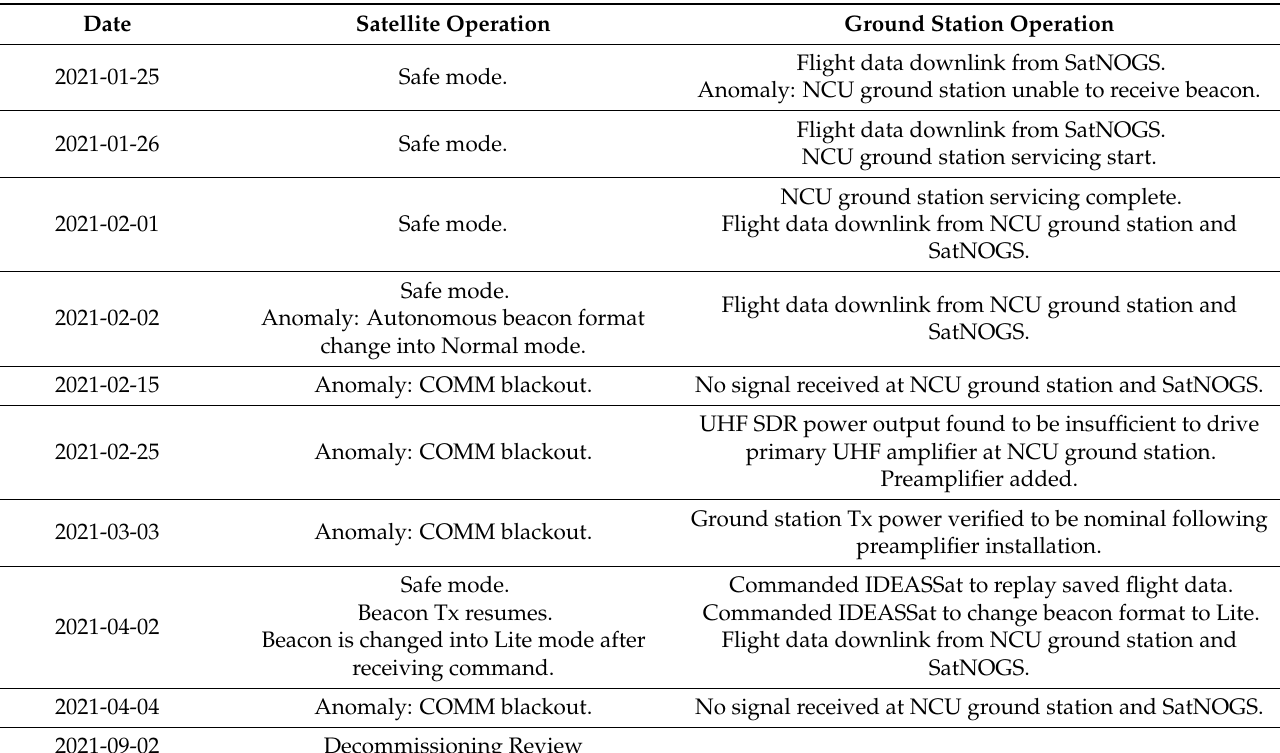
Table 11. IDEASSat on-orbit event